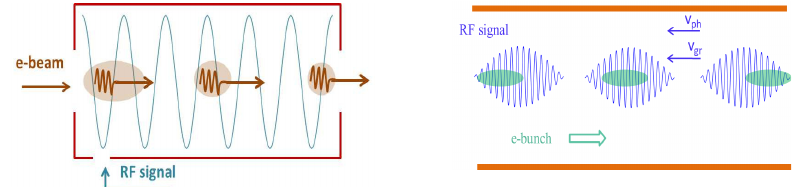
Figure 15. Compton backscattering with a standing wave ( left ). Compton scattering with a short pulse ( right ). The cavity filling time (lasting few ns) can be synchronized with repetition rate of the e-beam